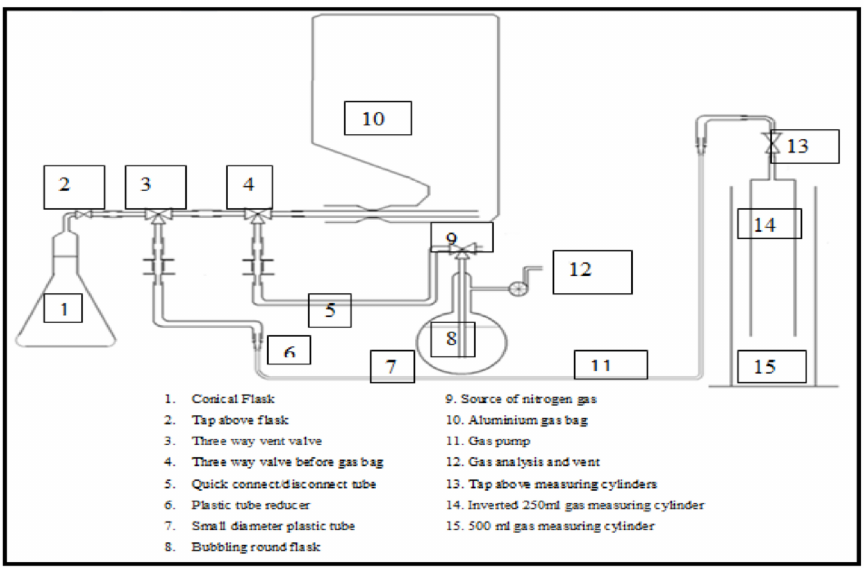
Figure 4. Apparatuses and equipment used in the preparation of the samples. Reproduced from [154], Energies: